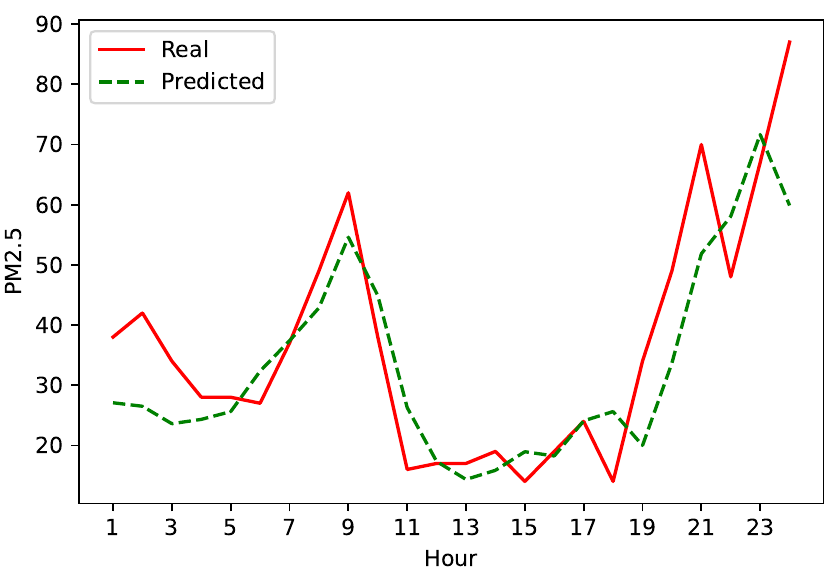
Figure 6. Comparison of real and one-hour-ahead values of PM 2.5 at the Cerro Navia station during 9 August